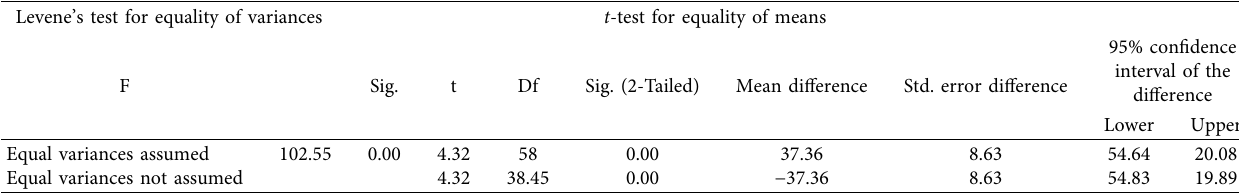
Table 4: Inferential statistics of the experimental and control groups in the anxiety posttests.